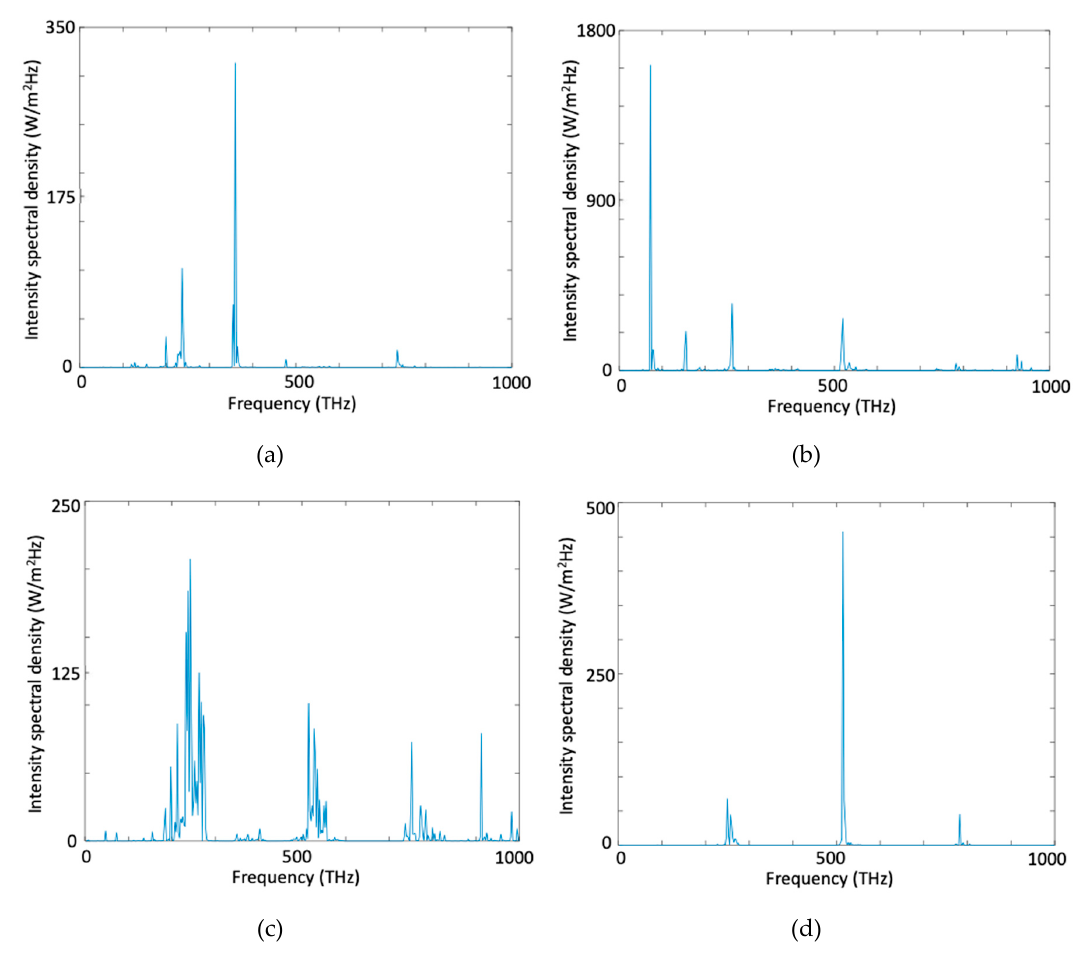
Figure 9. Spectrum of the total wave inside the cavity, measured at x = 5.73 μ m, t = 10 ps, at ( a ) 6th, ( b ) 14th, ( c ) 24th, and ( d ) 33rd iteration of the optimization process for harmonic generation at 515 THz.